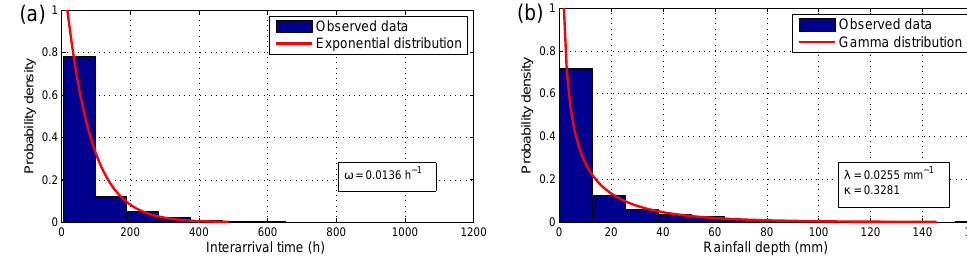
Figure 3. Fitted distributions to inter-arrival times (a) and rainfall depths (b) for 32 years of data in Lugano.